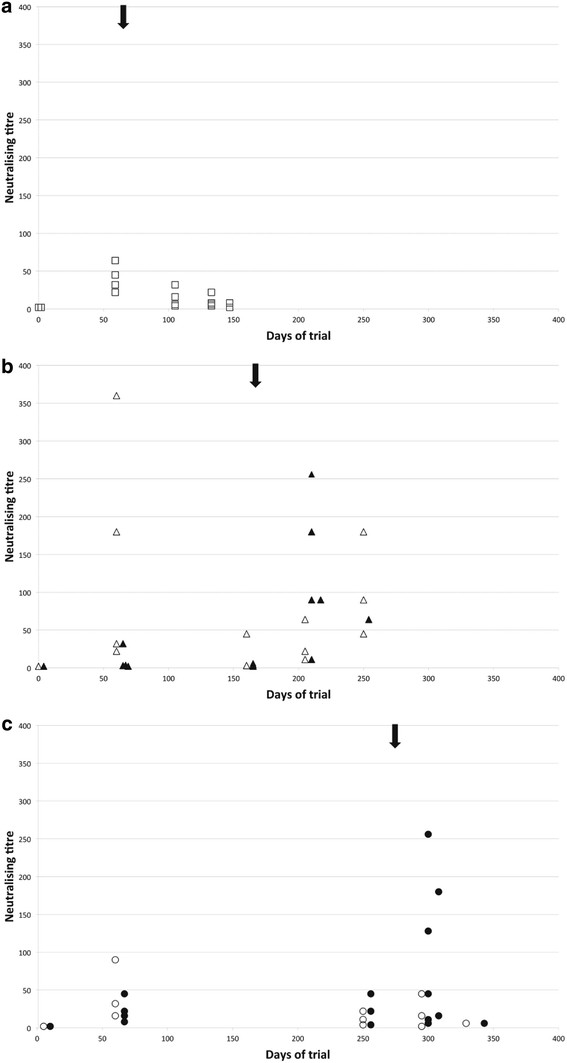
Virus neutralising titres observed in nasal secretion samples from vaccinated animals in groups 2–4 at a range of time-points. The arrow above each graph indicates the timing of challenge for that group. Samples from animals in group 2 (panel A) are represented by squares, group 3 (panel B) by triangles and group 4 (panel C) by circles. Filled symbols represent animals that succumbed to MCF while open symbols represent animals protected by vaccination.